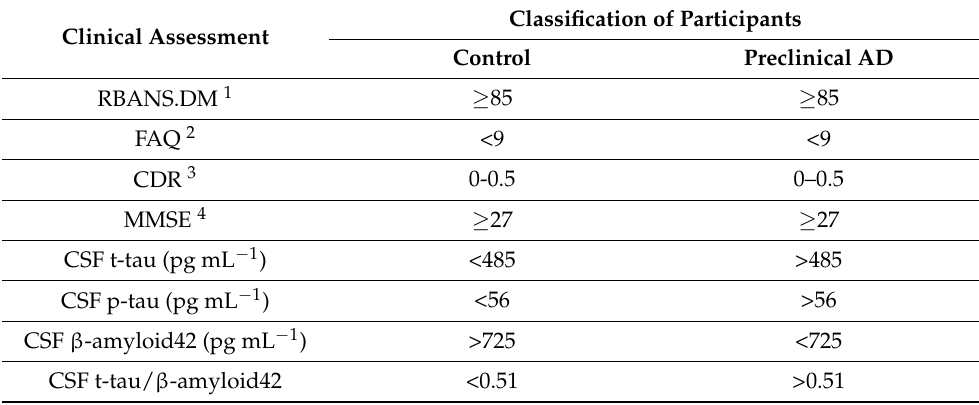
Table 1. Clinical assessment to classify the study participants. Clinical